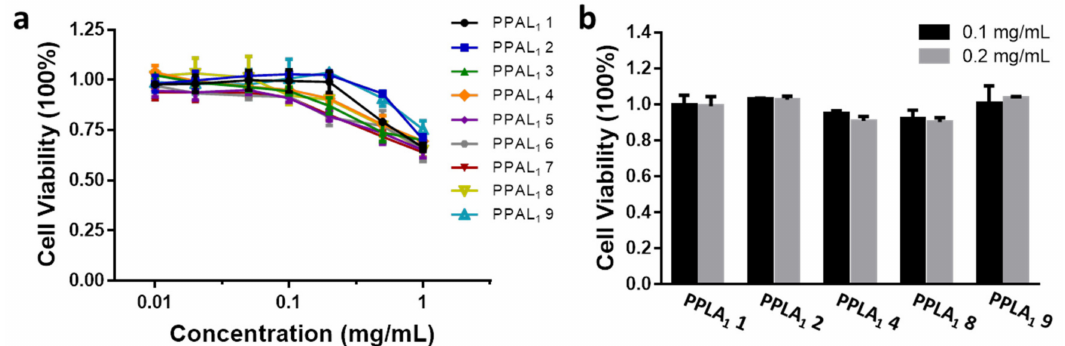
Figure 6. In vitro cytotoxicity of PPAL 1 1–9 copolymers in HeLa cells at various concentrations ( a ) and PPAL 1 1 , 2 , 4 , 8 and 9 copolymers with cell survival up to 90% at 0.2 mg mL − 1 ( b